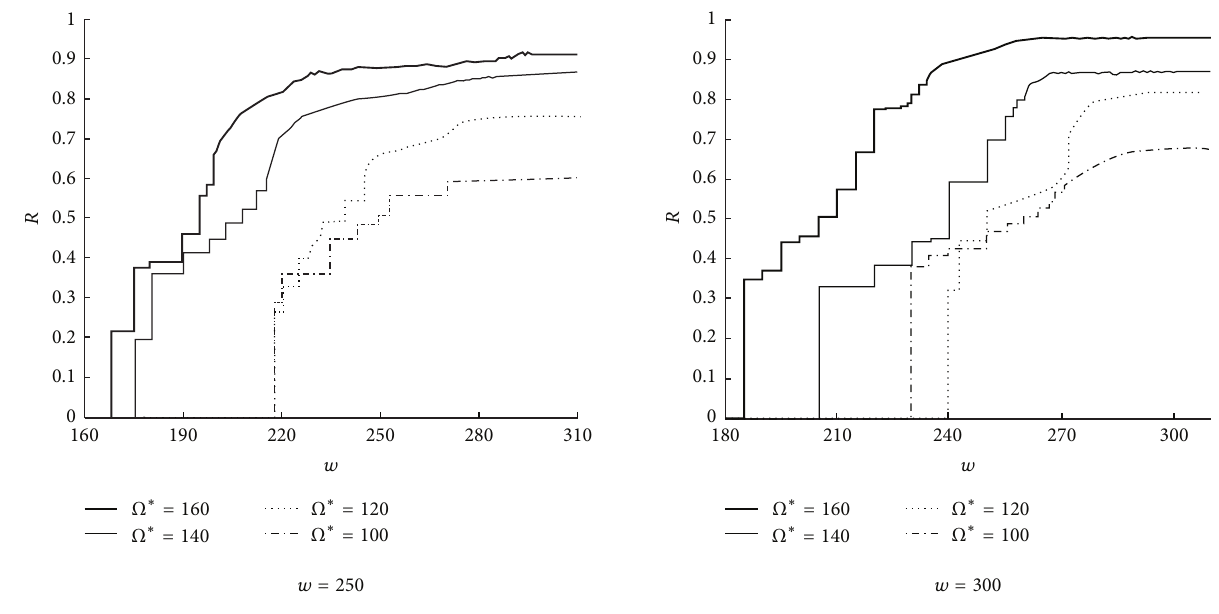
Figure 1: 𝑅(𝑤) functions for the solutions obtained.